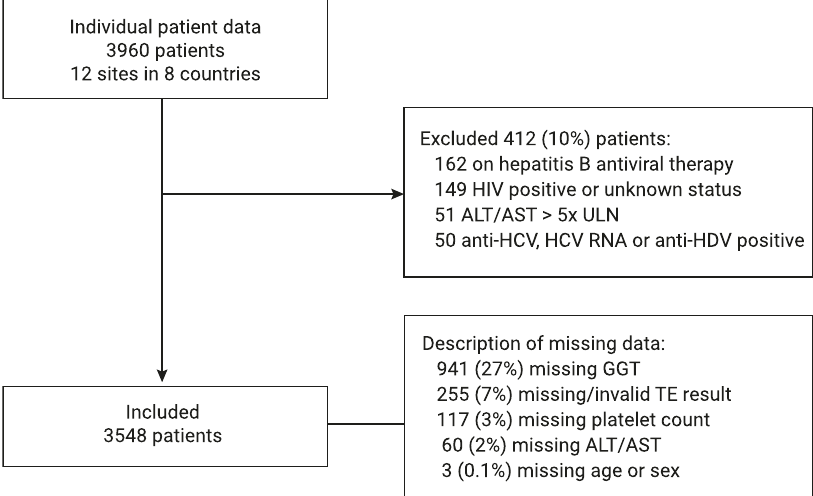
Fig. 2 | Flowchart ofdata sources. HIV humanimmunode fi ciencyvirus, ALTalanine aminotransferase, AST aspartateaminotransferase, ULNupper limitof normal, HCV hepatitis C virus, HDV hepatitis D virus, GGT gamma-glutamyl transferase,TE transient